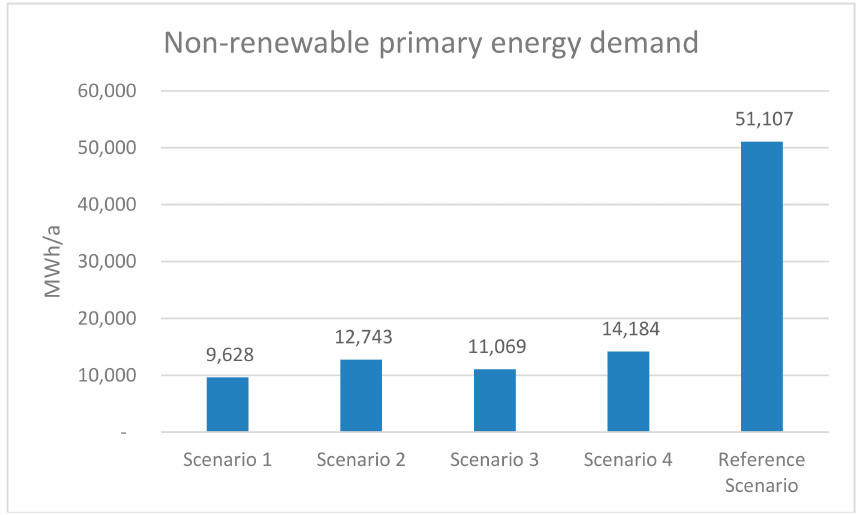
Figure 10. Non-renewable primary energy consumption by